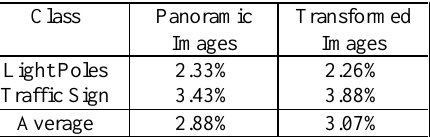
Table 3. IoU of the results from pre-trained FCN model.